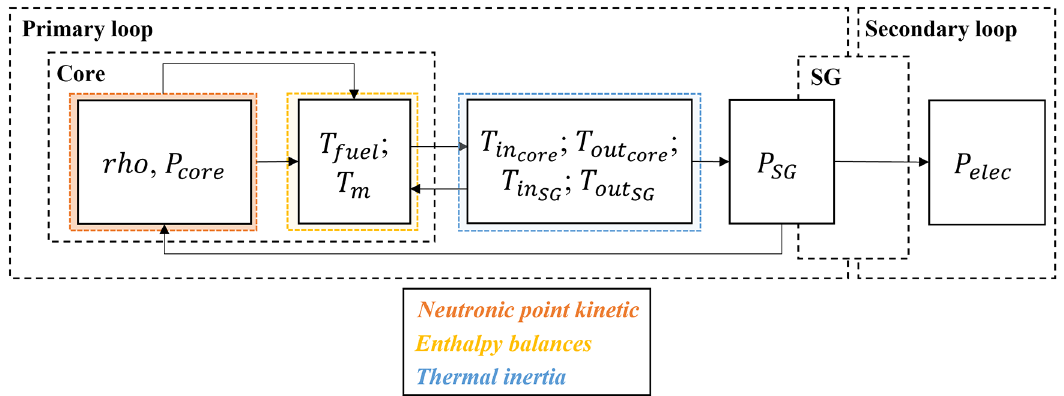
Fig. 7. Schematic of the quantities for the global modelling of the reactor.